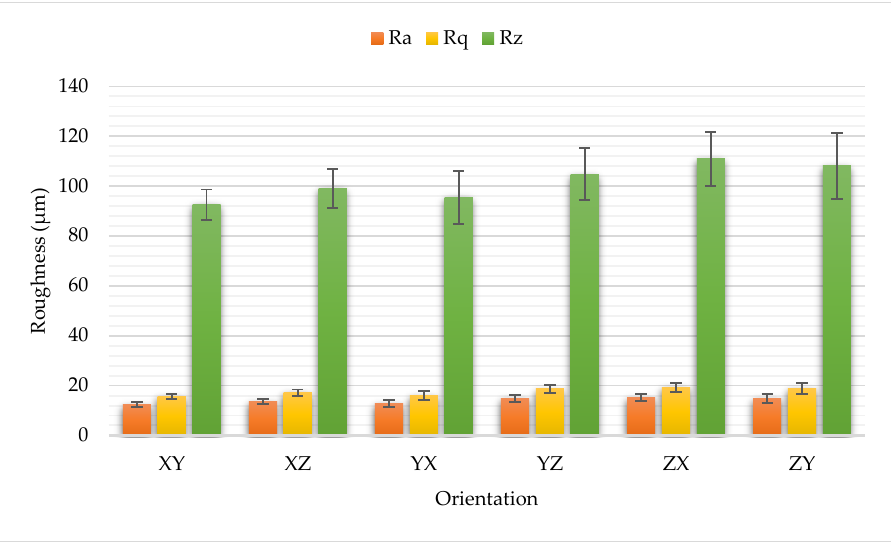
Figure 15. The average roughness and standard deviation of the polyamide 11 (PA11) samples grouped by orientation.